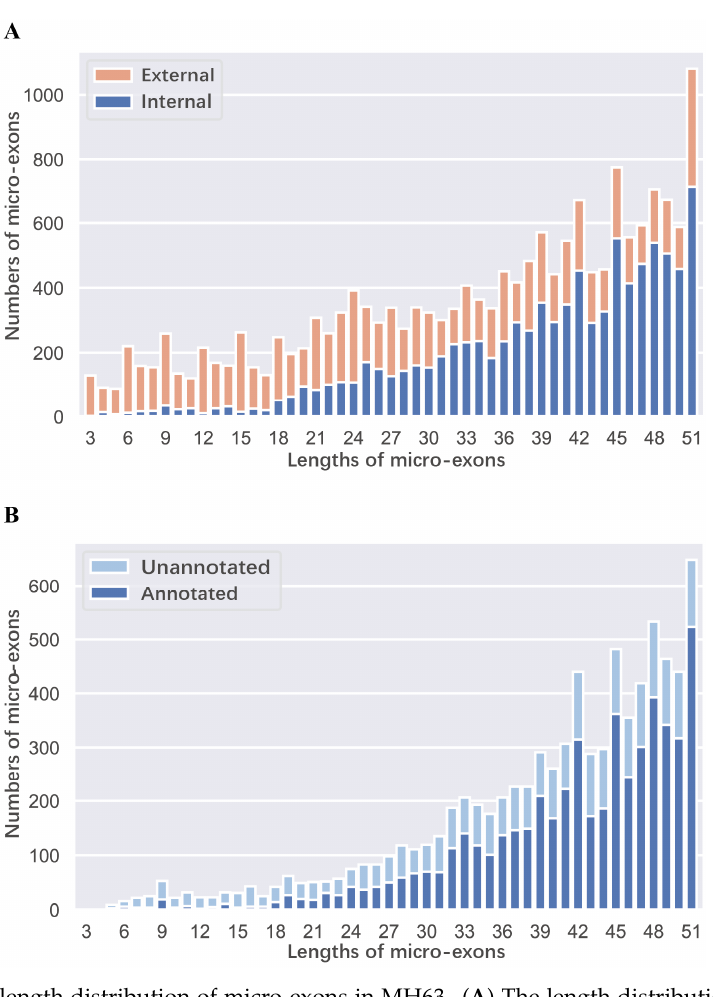
Figure 1. The length distribution of micro-exons in MH63. ( A ) The length distribution of external and internal micro-exons based on MH63 genome annotation. ( B ) The distribution of lengths for the annotated and unannotated micro-exons, which were identified from RNA-seq data in four tissues.